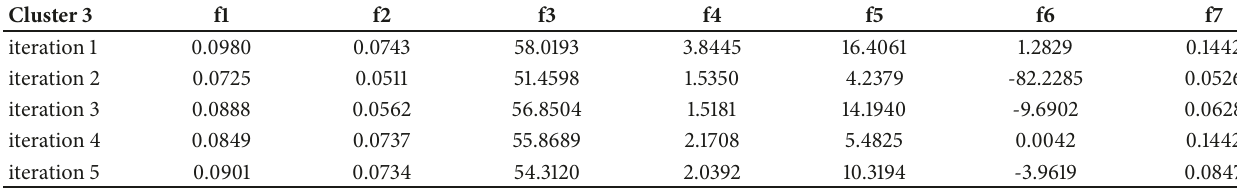
Table 10: Iterations for Cluster 3.